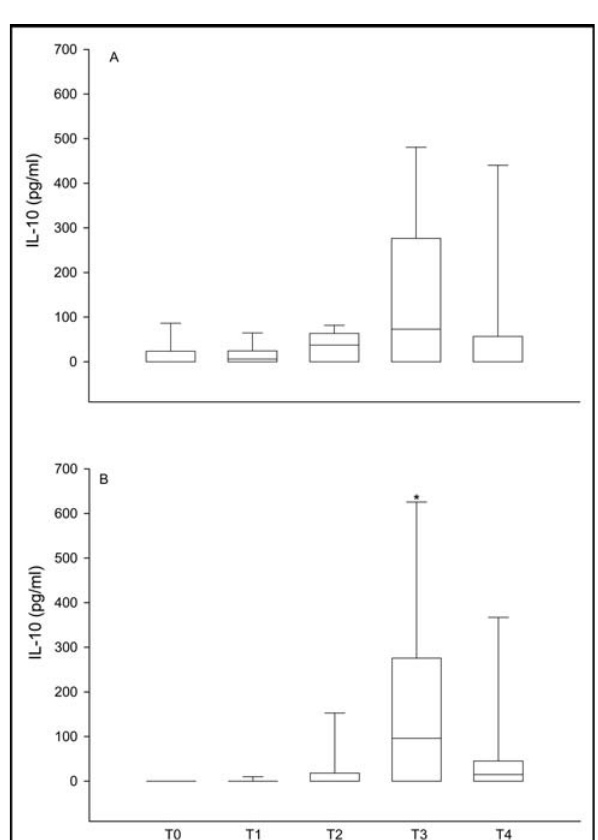
FIGURE 3 - Plasma IL-10 concentrations during and after bypass. Patients were submitted to bypass under normothermia with blood cardioplegia (n=10, panel A) or hypothermia with crystalloid cardioplegia (n=10, panel